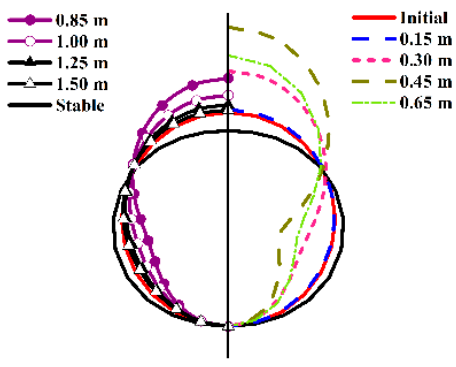
Figure 7. Deformed shape of the pipe during the installation.